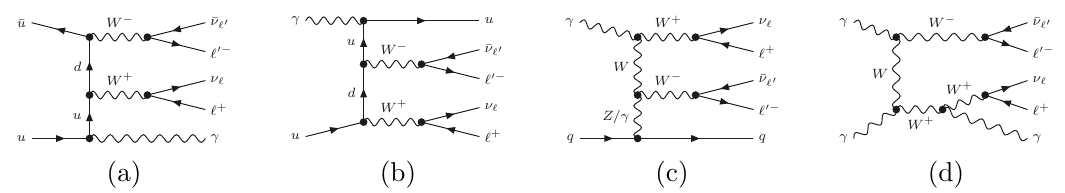
Figure 7 . Sample of real emission diagrams contributing to 2 ‘ 2 (cid:23) production in the di(cid:11)erent- (cid:13)avour case ( ‘ = ‘ 0 ) and in the same-(cid:13)avour case ( ‘ = ‘ 0 ), in the quark-antiquark channel (a), the 6 (anti-)quark-photon channel (b,c) and the photon-photon channel (d).